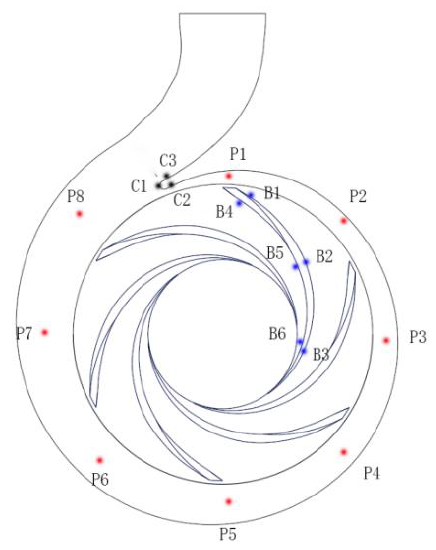
Figure 8. Monitoring points of the pressure fluctuations in the centrifugal pump.